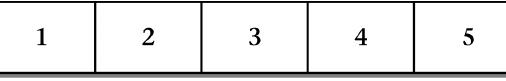
Figure 4: Similarities between